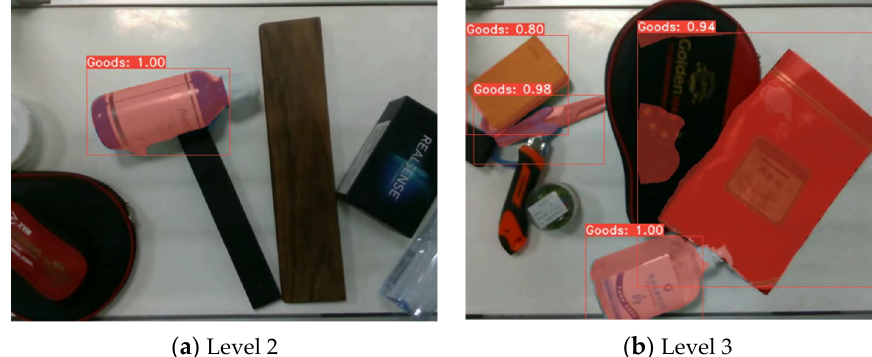
Table 4. OCIS results on videos. Figure 11. Poor results of YOLCACT on videos. Figure 11. Poor results of YOLCACT on